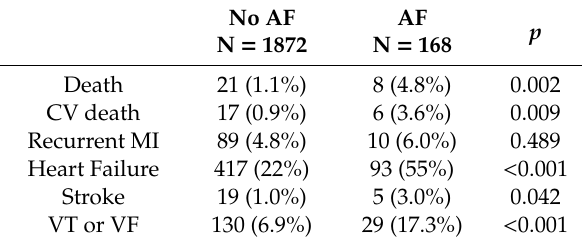
Table 4. In-hospital outcomes according to the onset of new AF during AMI n